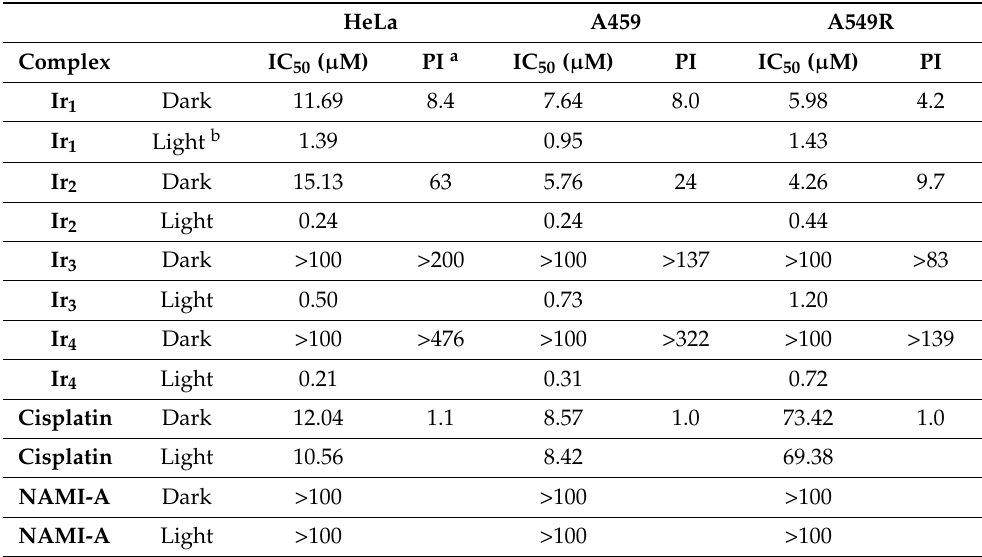
Table 1. Cytotoxicity and phototoxicity of complexes Ir 1 –Ir 4 , cisplatin and NAMI-A against cervical cancer (HeLa) and lung cancer (A459), (A549R) [55].